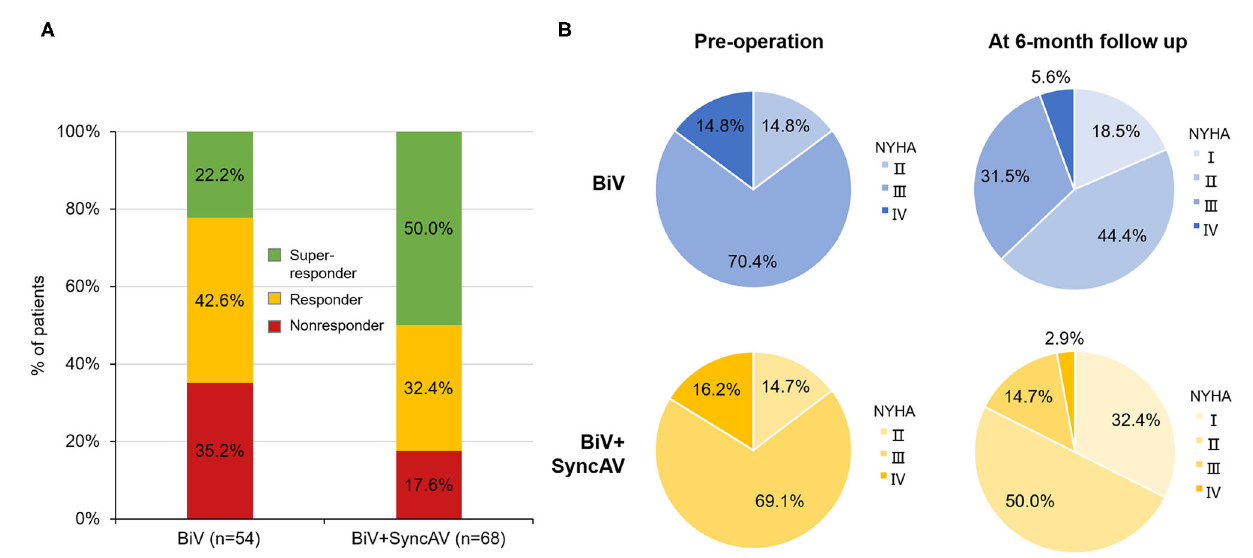
FIGURE 3 | (A) Proportion of non-responder, responder, and super-responder in the BiV + SyncAV group and BiV group; (B) New York Heart Association functional class (NYHA) at baseline and 6-month follow-up between BiV + SyncAV group and BiV group. BiV, biventricular pacing.